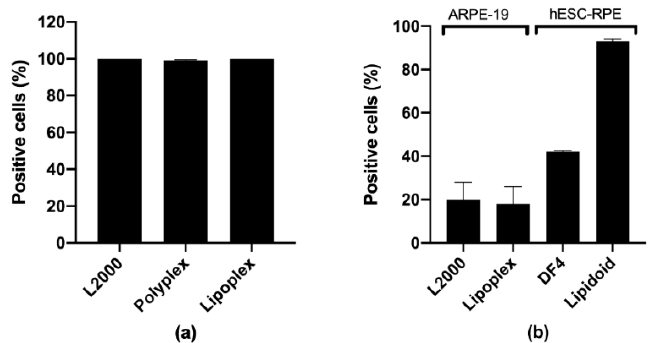
Figure 7. Percentage of positive ( a ) dividing ARPE-19 cells, and ( b ) differentiated RPE cells measured by flow cytometry upon 5 h of treatment with fluorescent siRNA/dsDNA incorporated into different carriers. Dividing ARPE-19 cells were transfected with 50 nM of FAM-IL-6 siRNA, the differentiated ARPE-19 with 100 nM of FAM-IL-6 siRNA, and the 4-week matured hESC-RPE with 50 nM of Alexa Fluor 488 dsDNA (21-mer). L2000: Lipofectamine 2000; DF4: DharmaFect 4. Data are presented as mean + SD, n = 3.